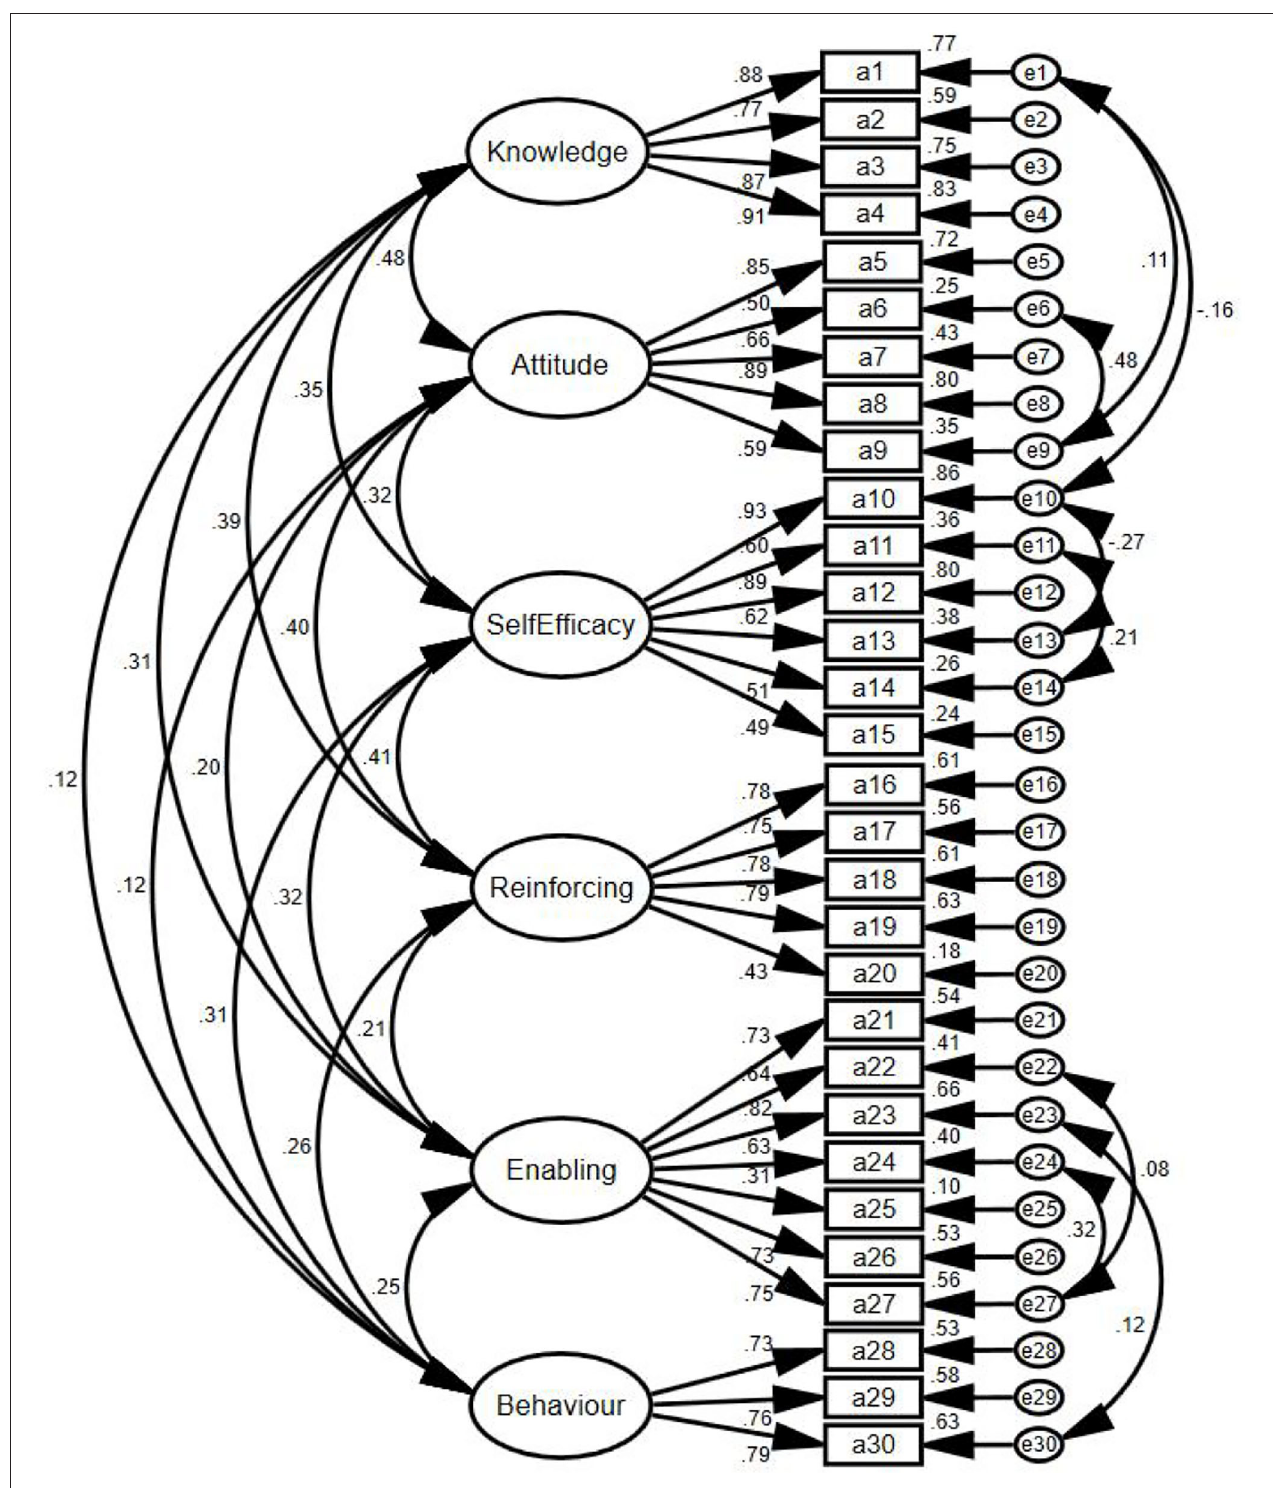
FIGURE 3 | Standardized six-factor structural model of the occupational low back pain prevention behaviors questionnaire.